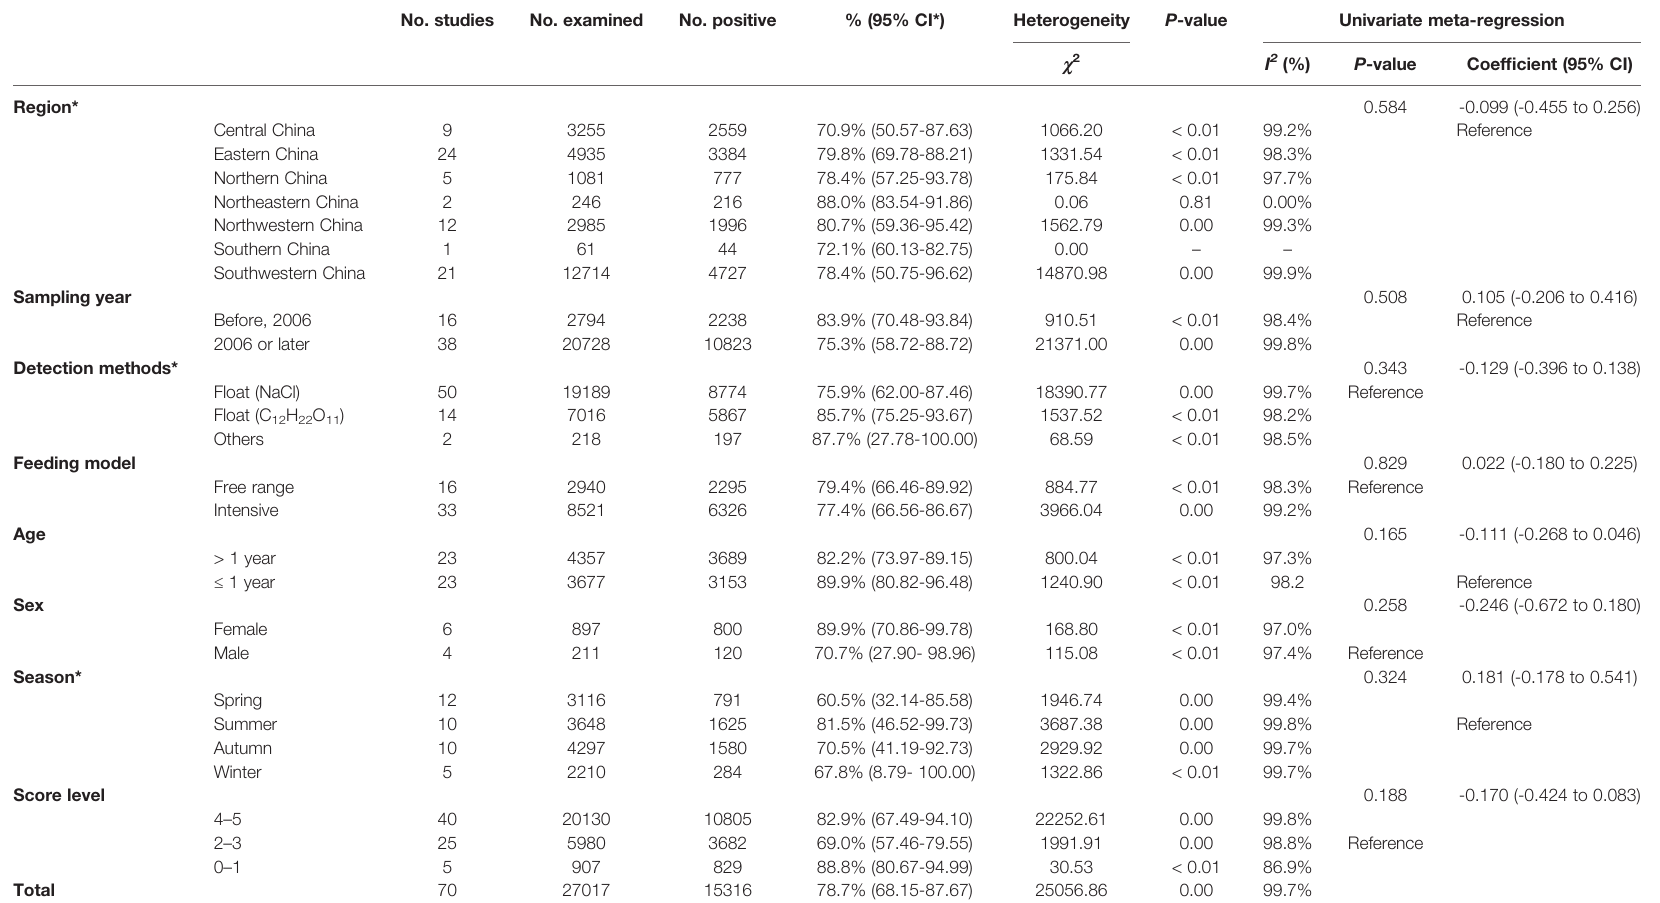
TABLE 2 | Pooled prevalence of Eimeria spp. infection in goats in China.